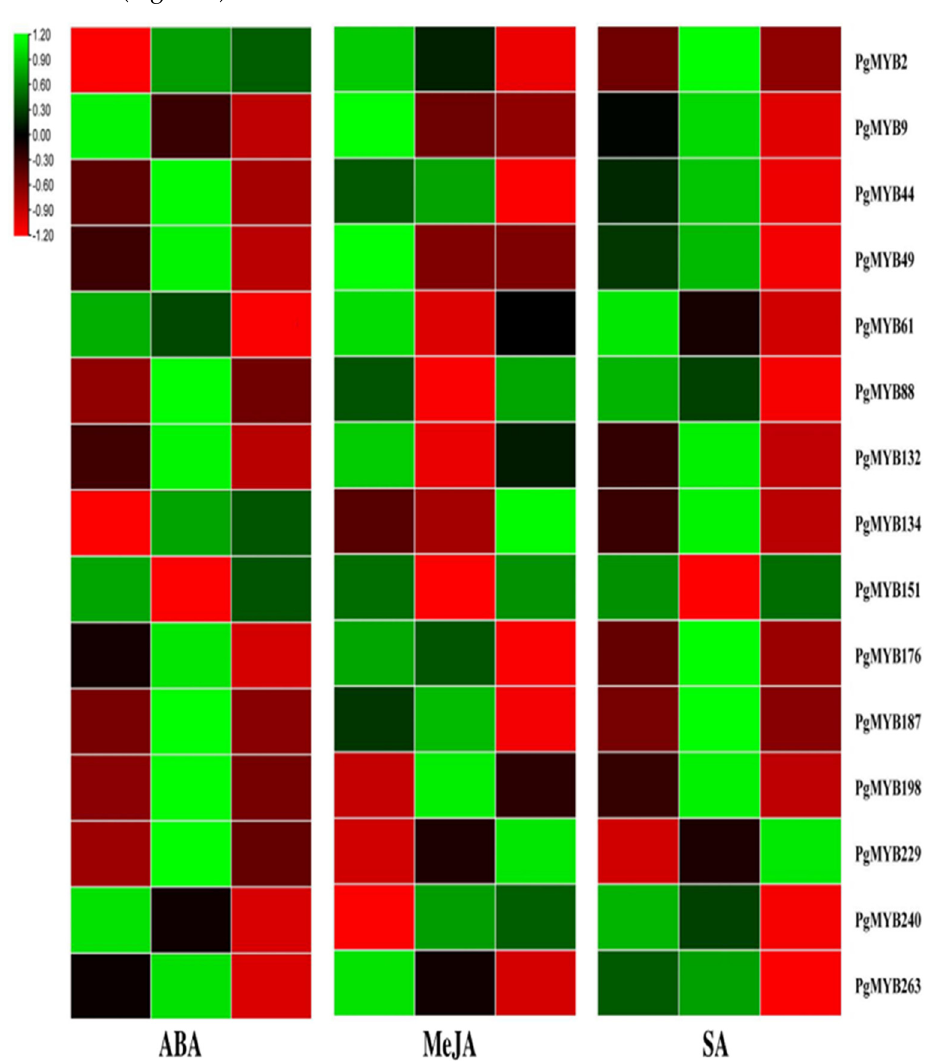
Figure 9. Heat map showing expression profile of PgMYB genes upon exogenous phytohormones (ABA, MeJA and SA) treatments at 0 h, 3 h and 24 h time points. The transcript abundance level has been normalized and hierarchically clustered. The heat map was generated using TBtools v0.66831. The ABA treatment led to the upregulation of PgMYB2 and PgMYB134 and downreg- ulation of PgMYB9 , PgMYB61 and PgMYB240 at 3 h and 24 h time points. We have also observed the upregulated expression of eight PgMYBs at the early time point (3 h),